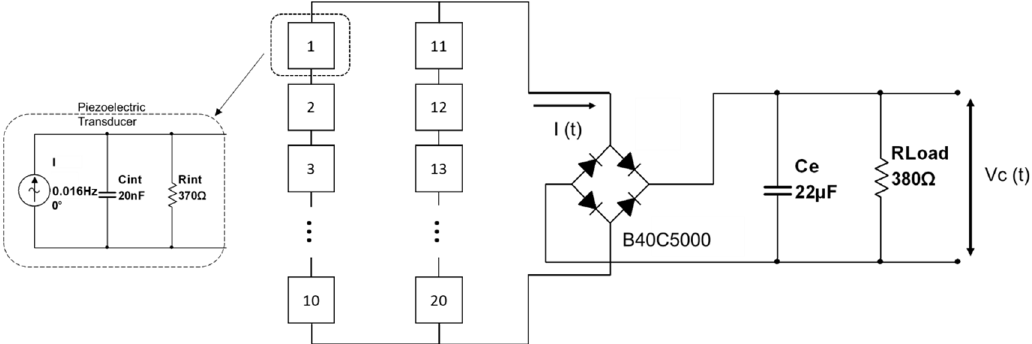
Figure 3. Full bridge circuit (based on [29]).